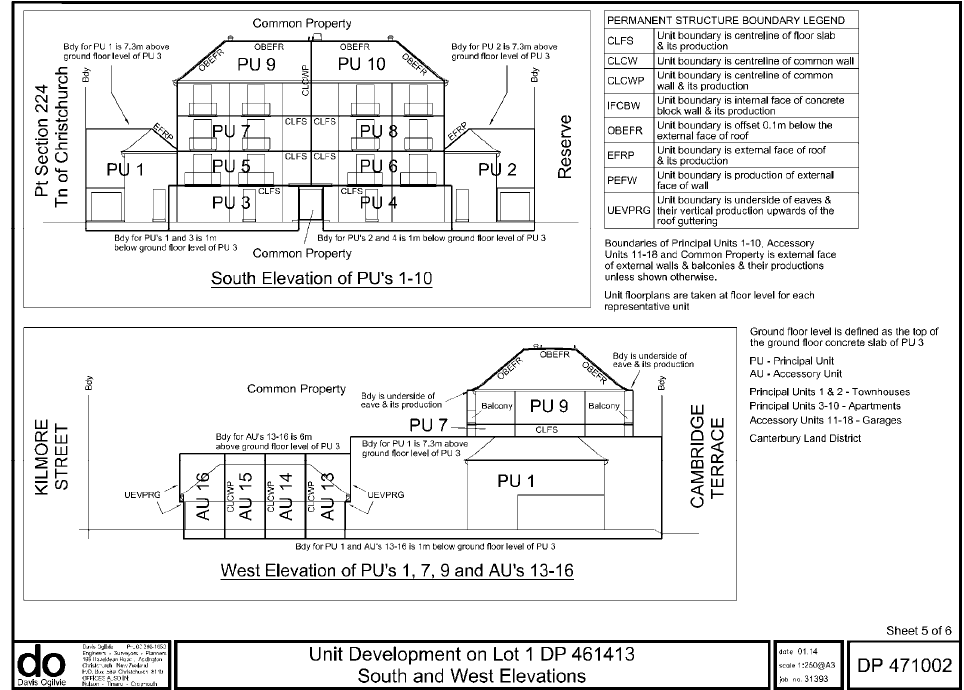
Figure 6. Elevation views of unit title development.